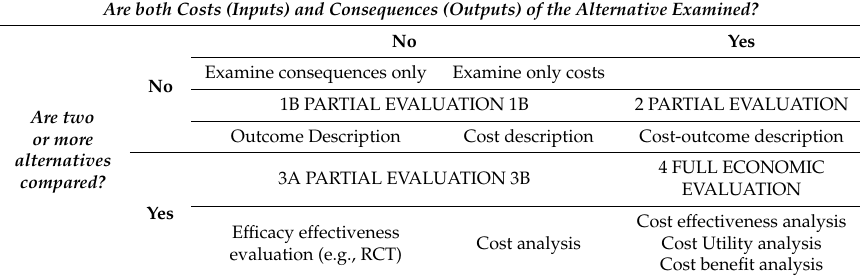
Table 1. Classification scheme for economic evaluations (Drummond 2005).